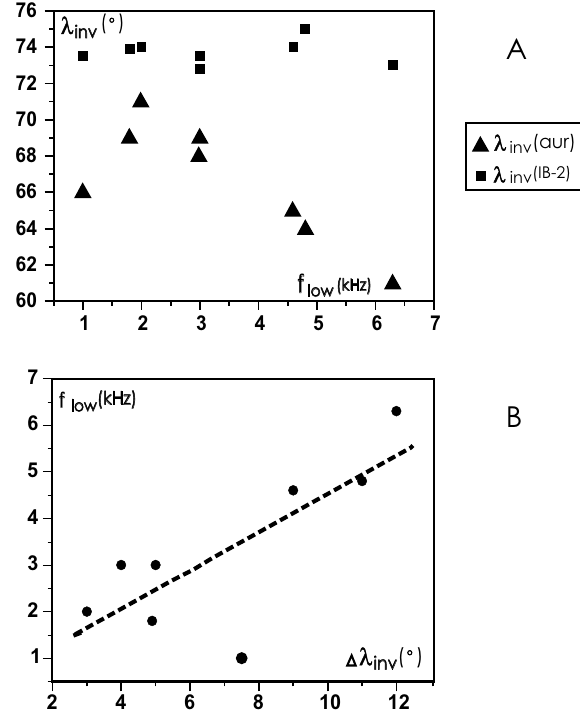
hiss and the distance from INTERBALL-2 footprint to aurora for weak disturbances. (a) Invariant latitudes of the INTERBALL-2 footprint (squares) and aurora (triangles) for different lower cut- off frequencies of auroral hiss. The greater the difference is be- tween latitudes of the aurora and the INTERBALL-2 footprint, the higher the low frequency cutoff is of auroral hiss on the satel- lite. (b) Dependence of auroral hiss cutoff frequency, f low , on the difference between the invariant latitudes of the INTERBALL- 2 footprint and aurora. The regression equation (dashed line) is f low (1λ inv ) =(0.4 ± 0.1) 1λ inv +(0.4 ± 1.0), the slope 1 f low / 1λ inv is equal to